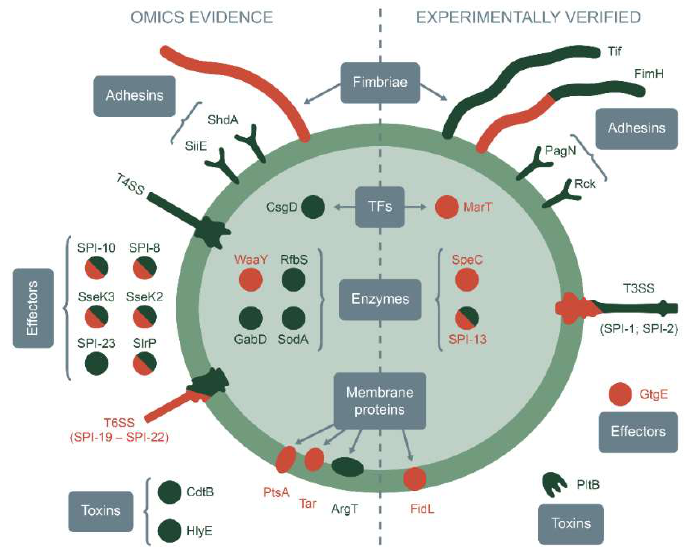
Figure 1. The main proteins and molecular systems involved in the host restriction of Salmonella strains. On the left side are the items supported by omics-derived data, and on the right are the ones supported by experimental evidence. Red color denotes the proteins, the absence of which increases the host restriction, and the green color denotes the proteins, the absence of which decreases it. Both colors are used when the absence of the protein might increase or decrease the host restriction depending on the context.